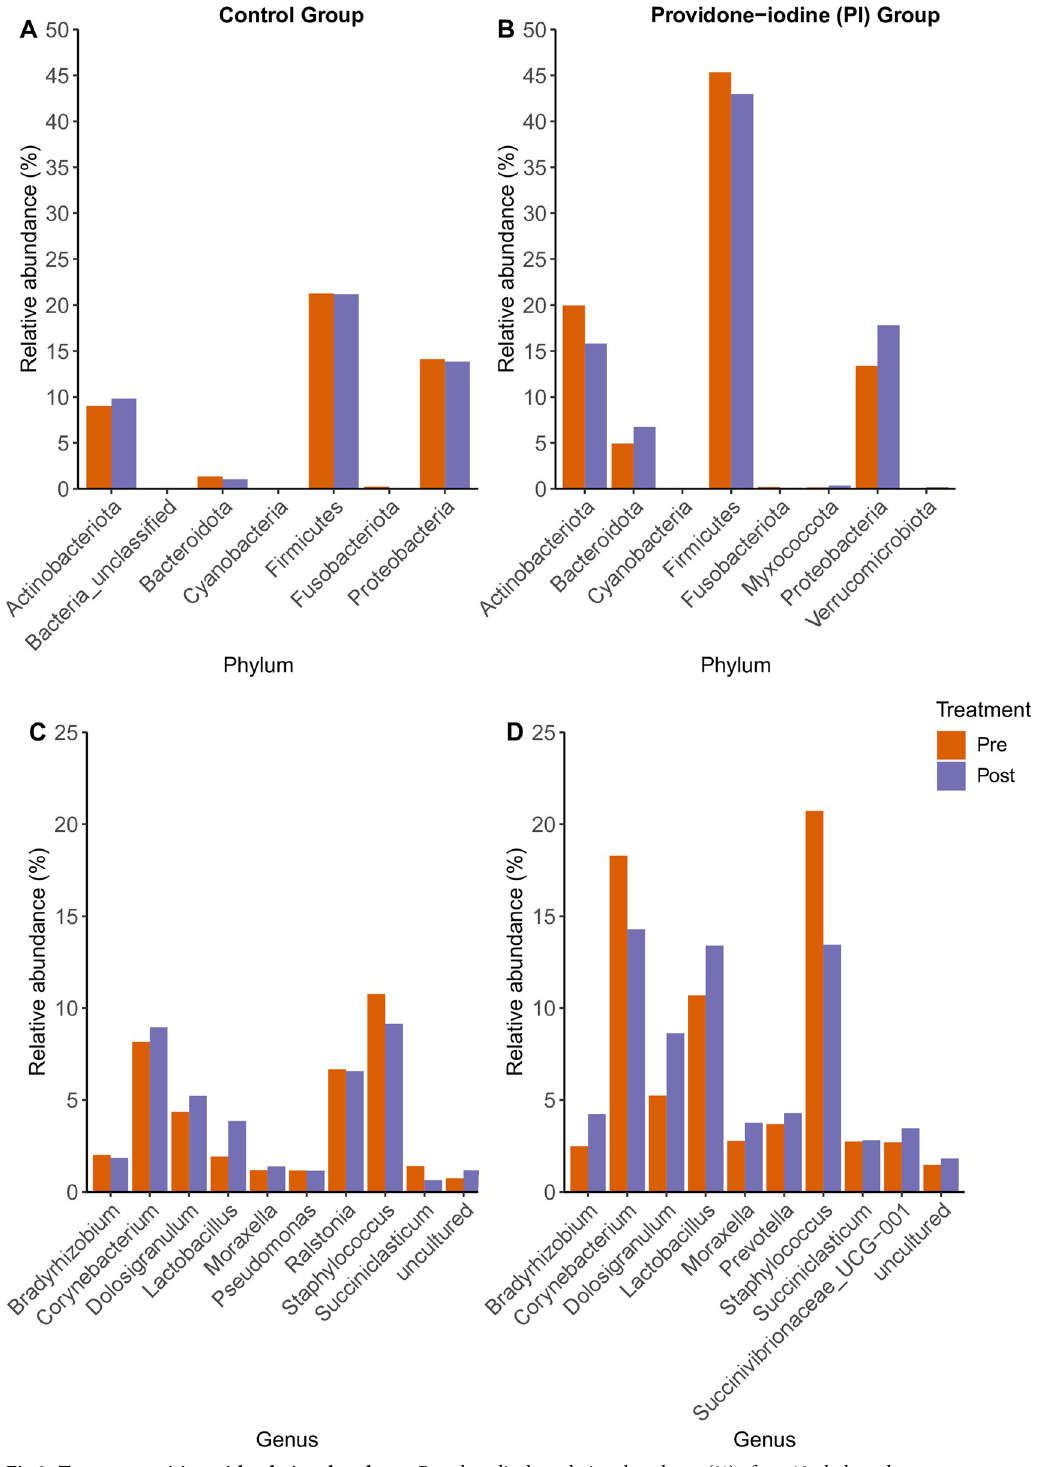
Fig 2. Taxa composition with relative abundance. Bar plots display relative abundance (%) of top 10 phyla and genera composition between pre- and post-surgery nasal microbiota in the control group (A and C) and PI group (B and D). Rare taxa are classified as “uncultured”. The legend displays the color coding of genera and phyla to which these taxa belong.